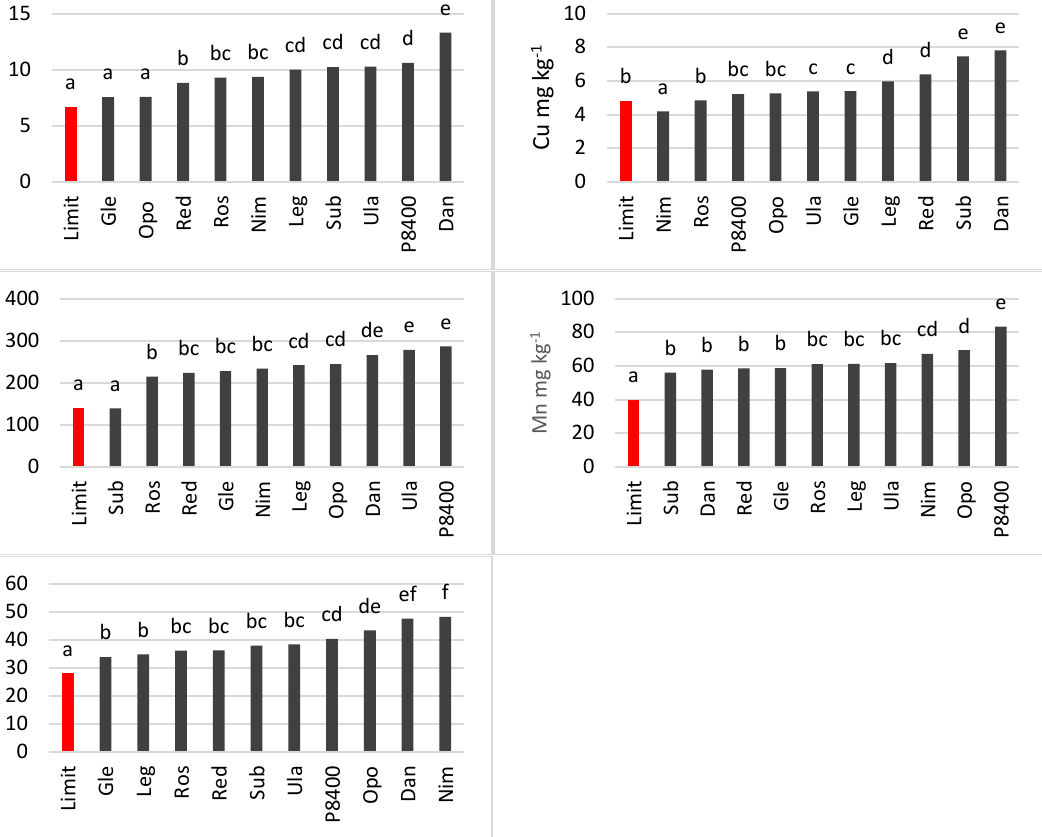
Figure 5. Concentration of microelements in shoots of maize cultivars. Bars marked with the same letters indicate no significant difference according to Tukey ’ s test ( p < 0.05).